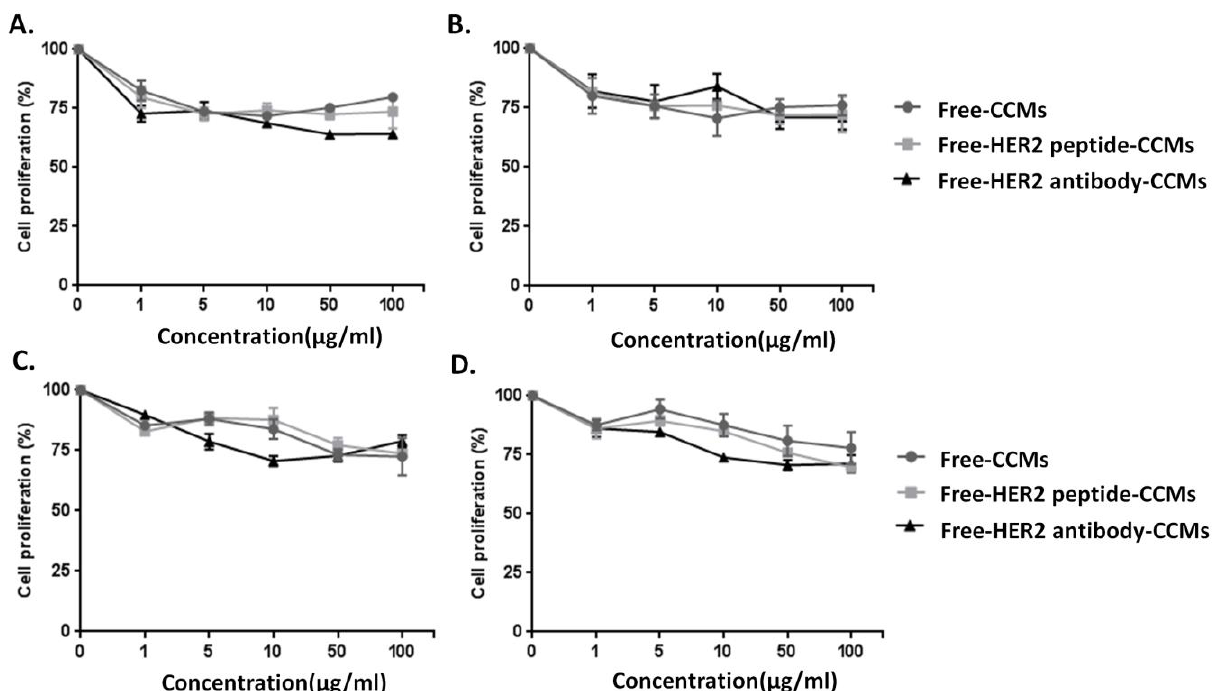
Figure 4. Cytotoxic effect of drug-free CCMs, HER2-peptide and HER2-antibody CCMs (0 – 100 µg/mL) on 48 and 72 h SKBR-3 breast cancer ( A : 48 h; B : 72 h) and MCF-10A ( C : 48 h; D : 72 h) cells.